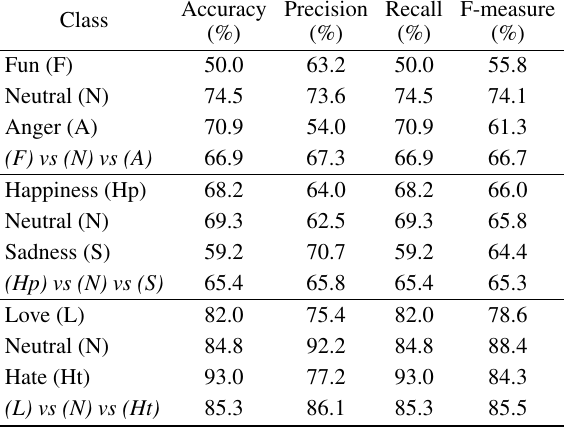
Table 3 Accuracy, Precision, Recall, and F-measure of the ternary classification.